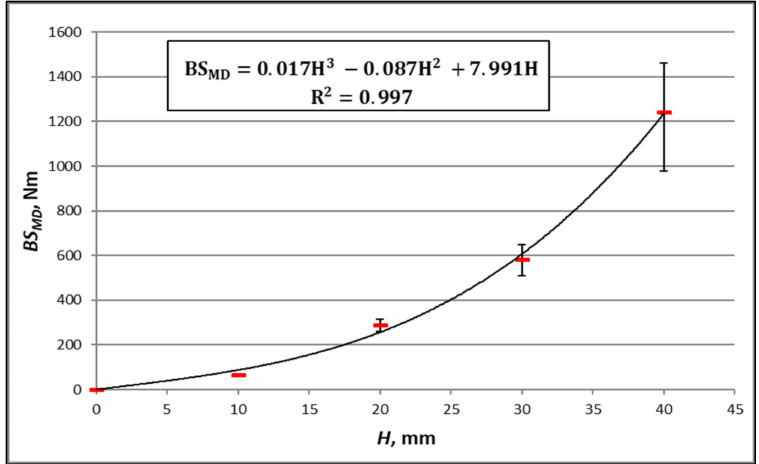
Figure 12. Measurements of BS MD boards TL200/FL140/TL200 with core cell size of D = 15 mm and different thicknesses.